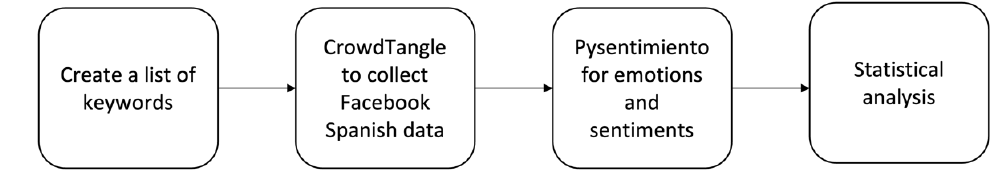
Figure 1. Facebook data collection